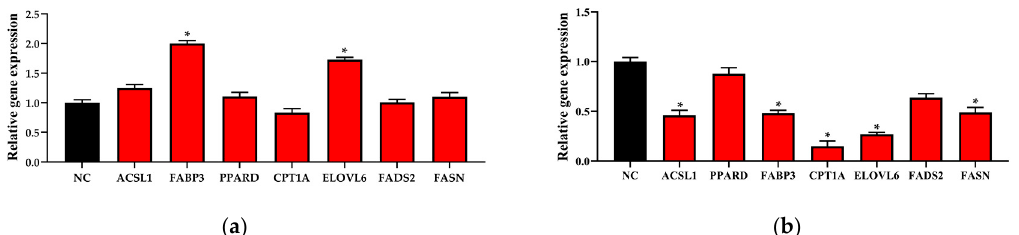
Figure 6. Lipid synthesis-related genes expression levels in bovine mammary epithelial cells (BMECs). ( a ) The lipid synthesis-related genes’ relative expression in BMECs after transfecting the pcDNA3.1-ACSL4 and pcDNA3.1. ( b ) The lipid synthesis-related genes’ relative expression in BMECs after transfecting the siRNA-323 and siRNA-NC. Values are presented as the mean ± standard errors; *, p < 0.05.